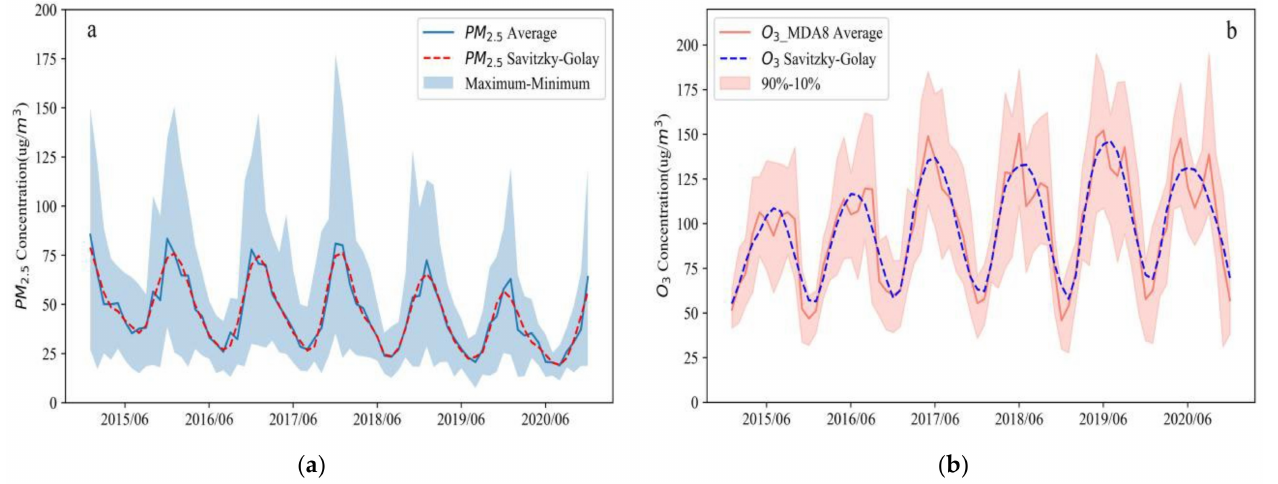
Figure 3. Monthly mean ( a ) PM 2.5 and ( b ) O 3 _MDA8 concentrations in the YRD from 2015 to 2020. In ( a ), the blue area represents the maximum and minimum daily mean PM 2.5 concentrations in that month. In ( b ), the pink area represents the 10th–90th percentiles of O 3 _MDA8 concentrations in that